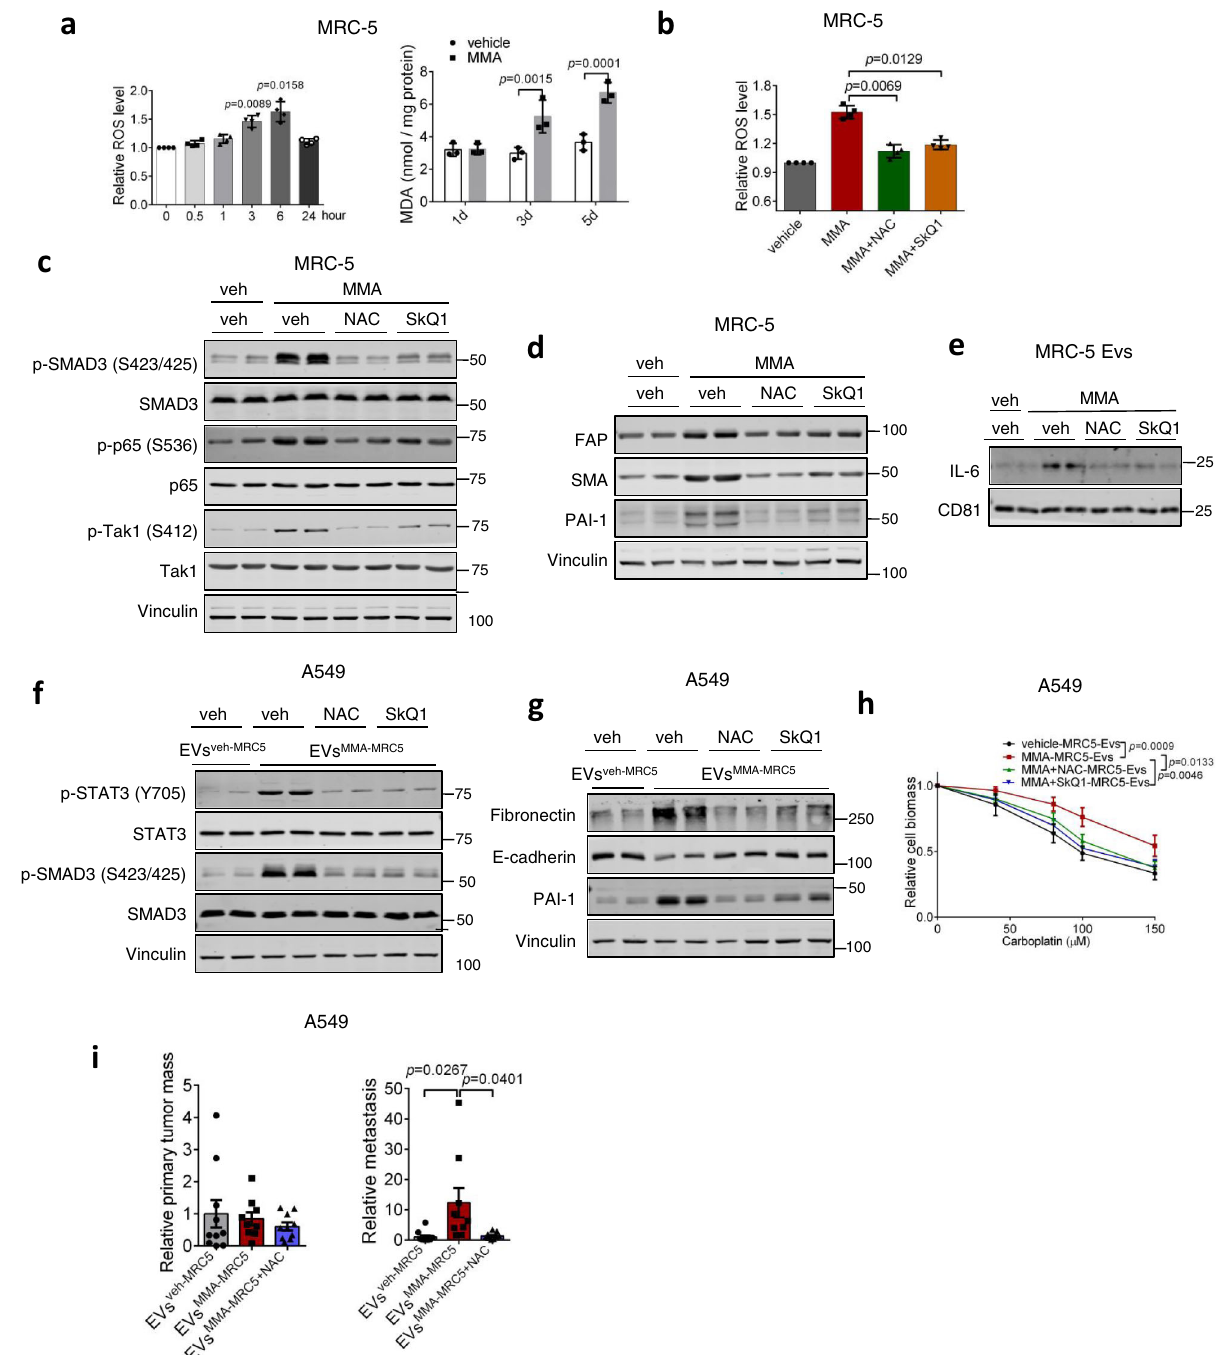
Fig. 5 | TGF- β and NF- κ B mediated activation of fi broblasts and EV-associated IL6 secretion occurs downstream of ROS generation. a (left) ROS levels and (right) MDA levels in MRC-5 fi broblasts after 1mM MMA treatment ( n =4 inde- pendent experiments for ROS measurement, mean±SEM, one-way ANOVA; n =3 independent experiments for MDA measurement, two-sided paired t -test). b ROS levelsinMRC-5 fi broblastsafterMMAtreatment aloneorin combinationwithNAC or SkQ1( n =4 independent experiments, mean±SEM, two-sided paired t -test). c , d Immunoblots of MRC-5 fi broblasts treated with MMA alone or in combination with NAC or SkQ1 for 6h ( c ) or 5 days ( d ). e Immunoblots showing IL-6 amount in EVsfromMRC-5 fi broblastsafterMMAtreatmentaloneorincombinationwithNAC orSkQ1. f Immunoblotsmeasuring signaling activationinA549 cellstreated for3h